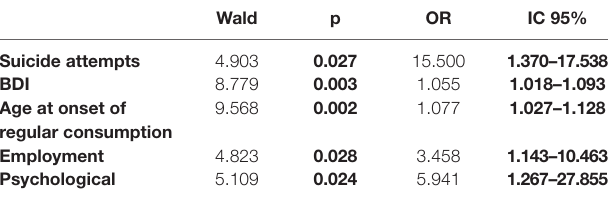
TABLE 4 | Logistic regression